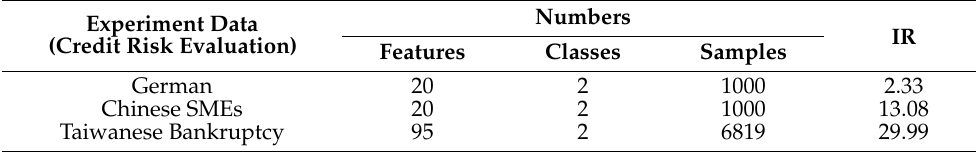
Table 2. Information of credit data